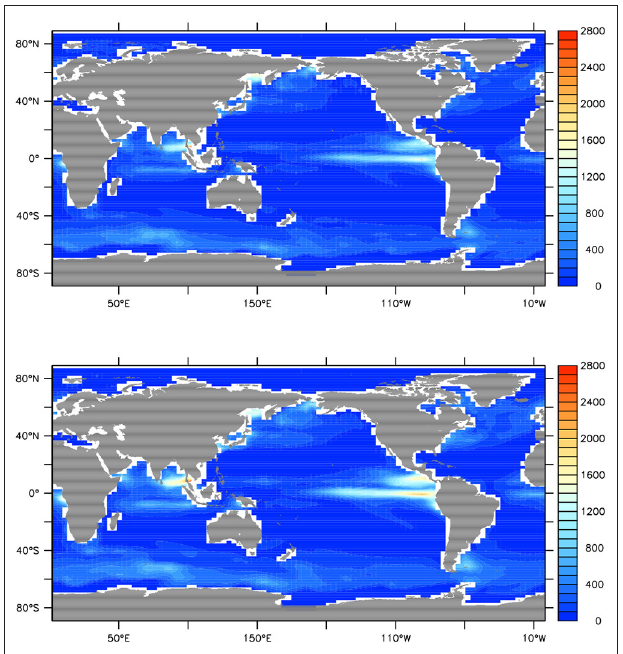
FIGURE 2 | Model year 2000 net primary production (Top) and zooplankton grazing rates (Bottom) in g C y − 1 . Values are integrated across depth and therefore values are larger for zooplankton grazing.